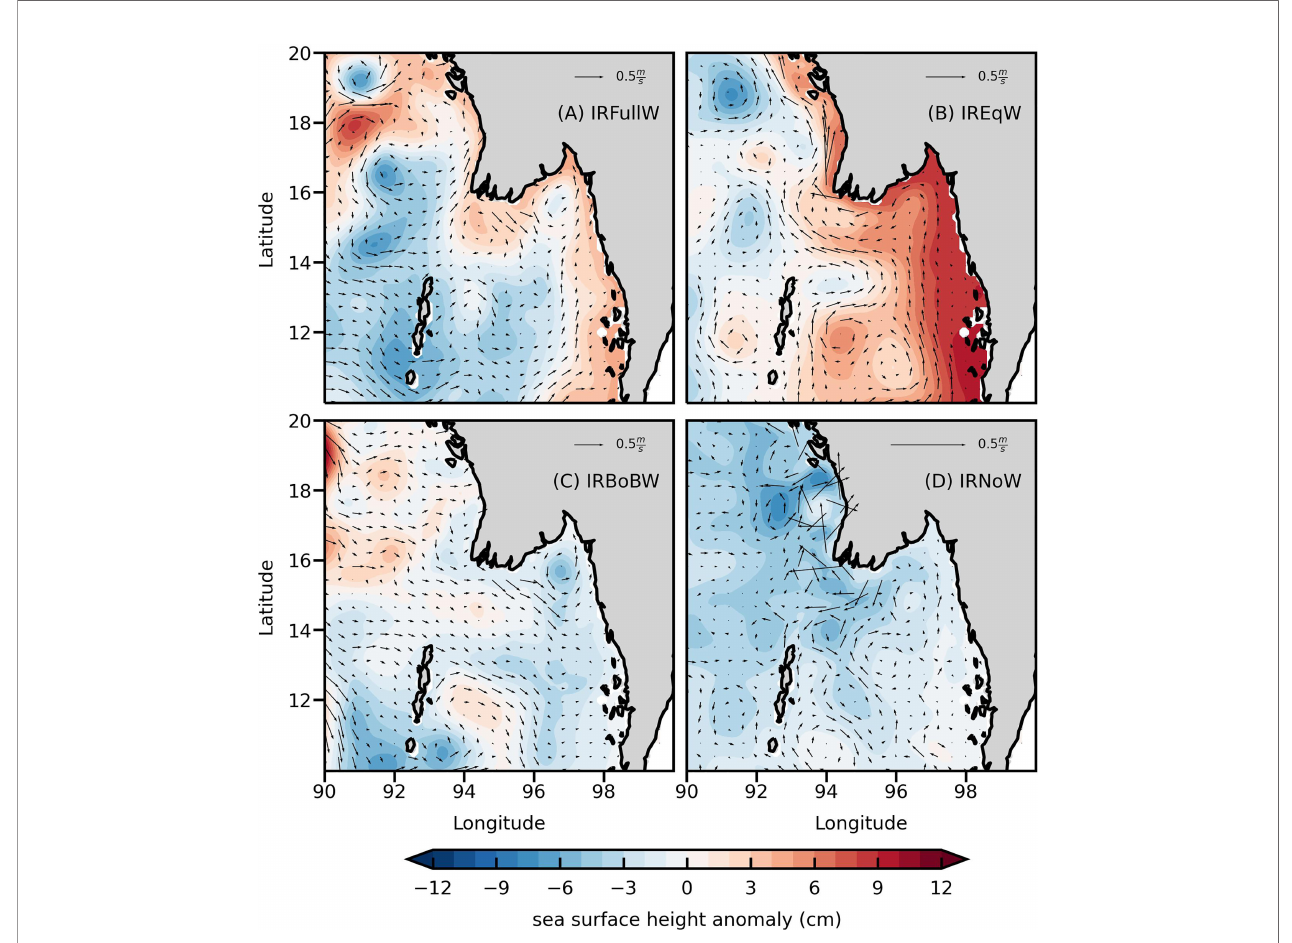
FIGURE 10 | Maps of monthly averaged sea surface height anomaly and surface currents(ms -1 ) for the month of May from the fi rst year of